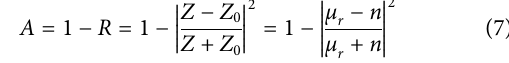
Frontiers in Physics |